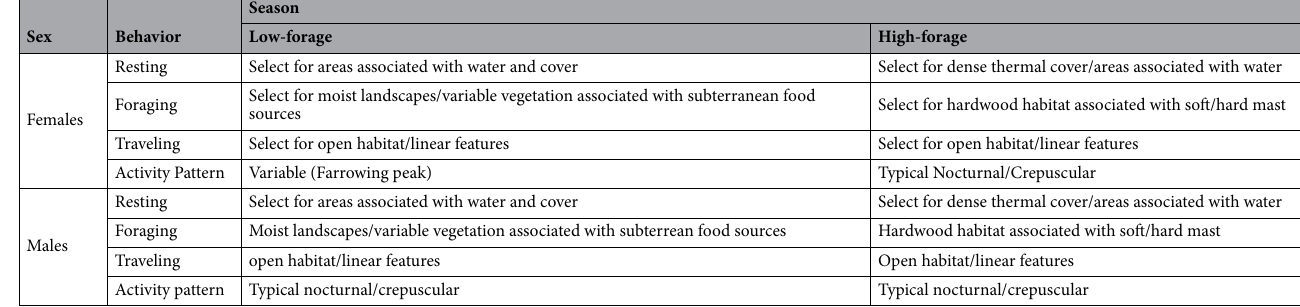
Table 1. Hypotheses for activity patterns and resource selection for three behavioral states (i.e., resting, foraging, traveling) for female and male wild pigs ( Sus scrofa ) on the Savannah River Site in South